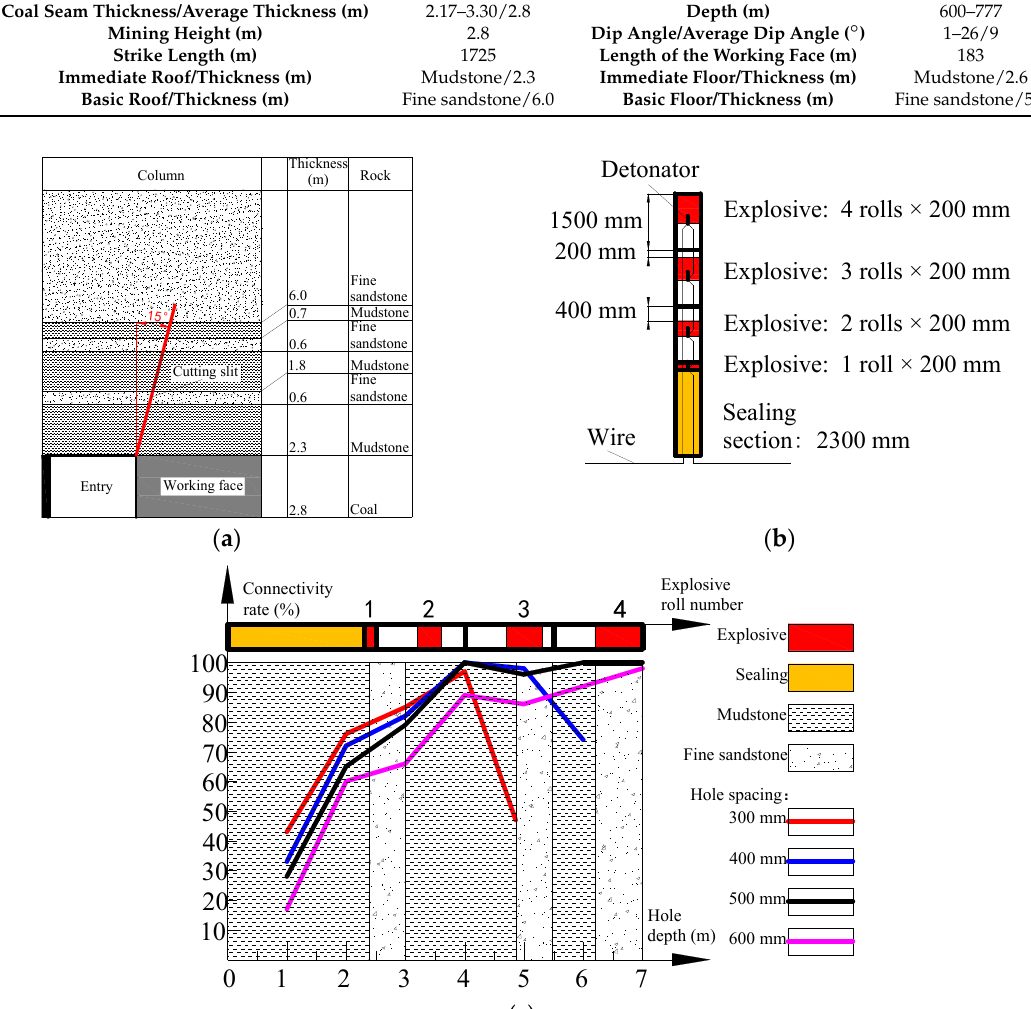
Table 4. Basic parameters of the II632 working face in the Hengyuan Coal Mine.